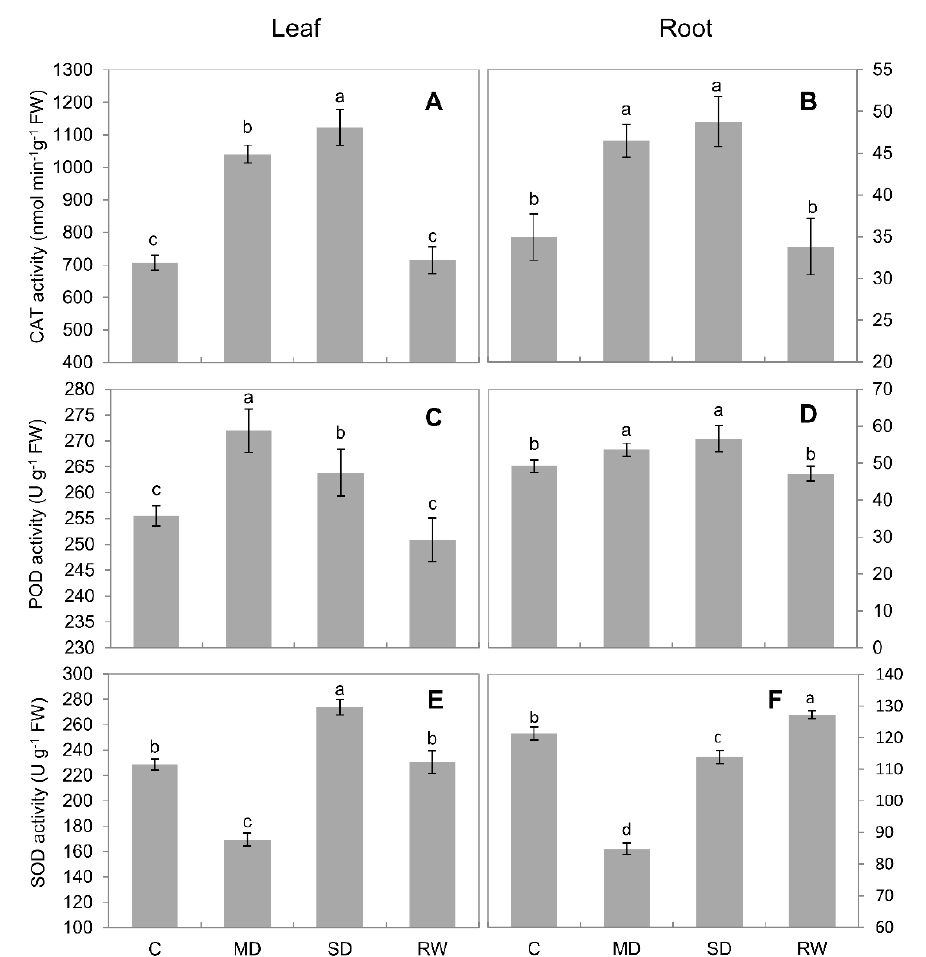
Figure 4. Antioxidant enzyme activity in C. duriuscula in response to drought stress. C-control, MD-mild stress, SD-severe stress, RW-re-watering. ( A , B ) CAT activity. ( C , D ) POD activity. ( E , F ) SOD activity. Data are means ± SE ( n = 3–6). Data labeled with different lower-case letters are significantly different at p < 0.05.